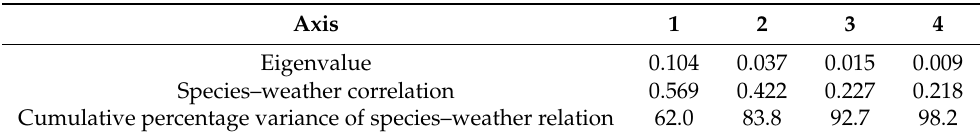
Table 4. Results of ordination of the canonical correspondence analysis accounted for the first four axes.